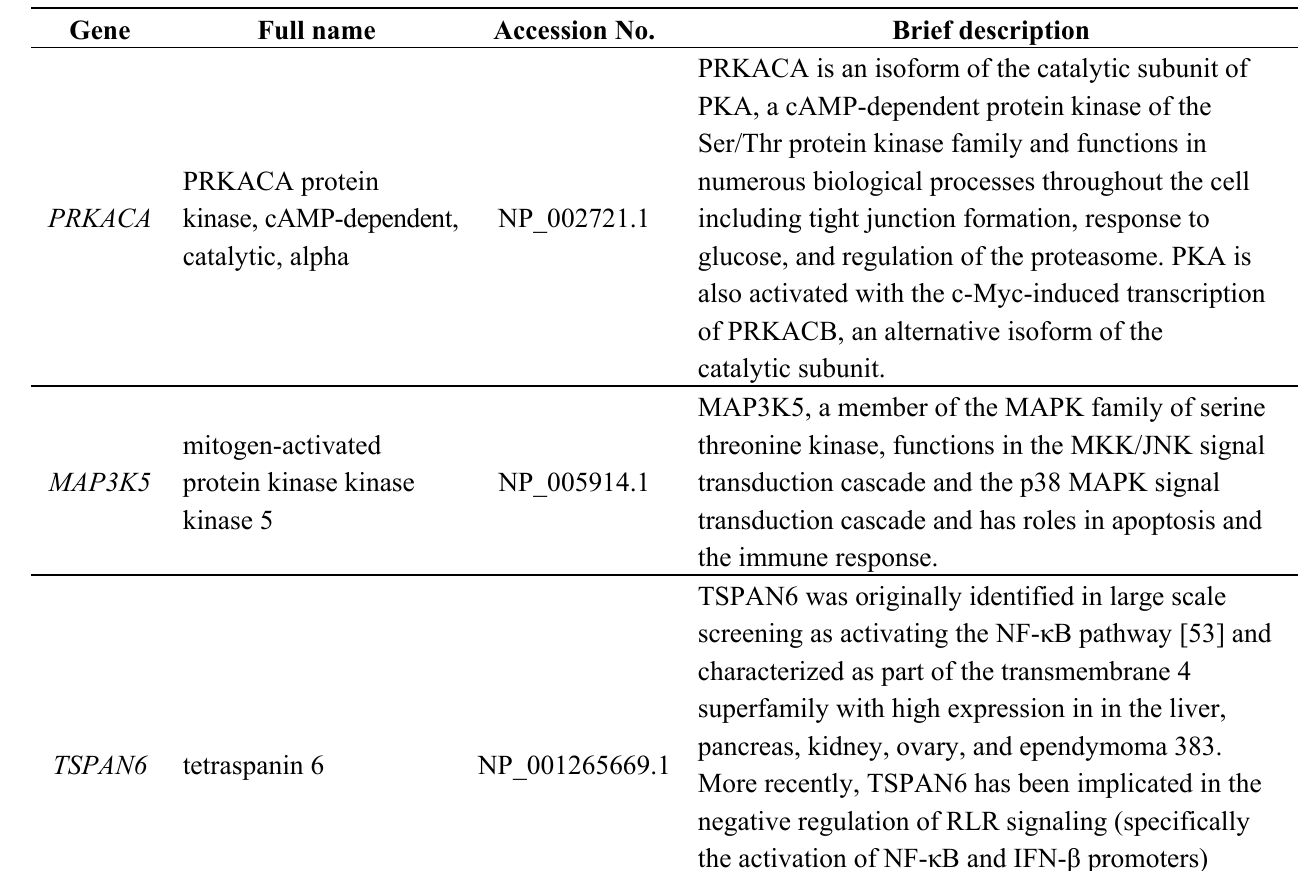
Table 3. Signal transduction (10